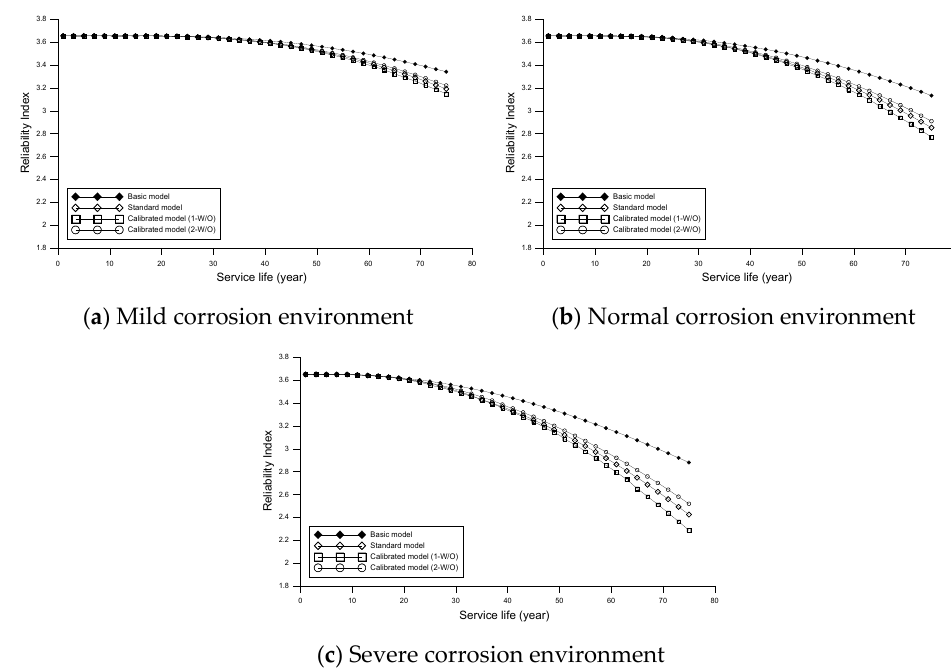
Figure 10. Reliability degradation under heavy traffic characteristics (with previous inspection).